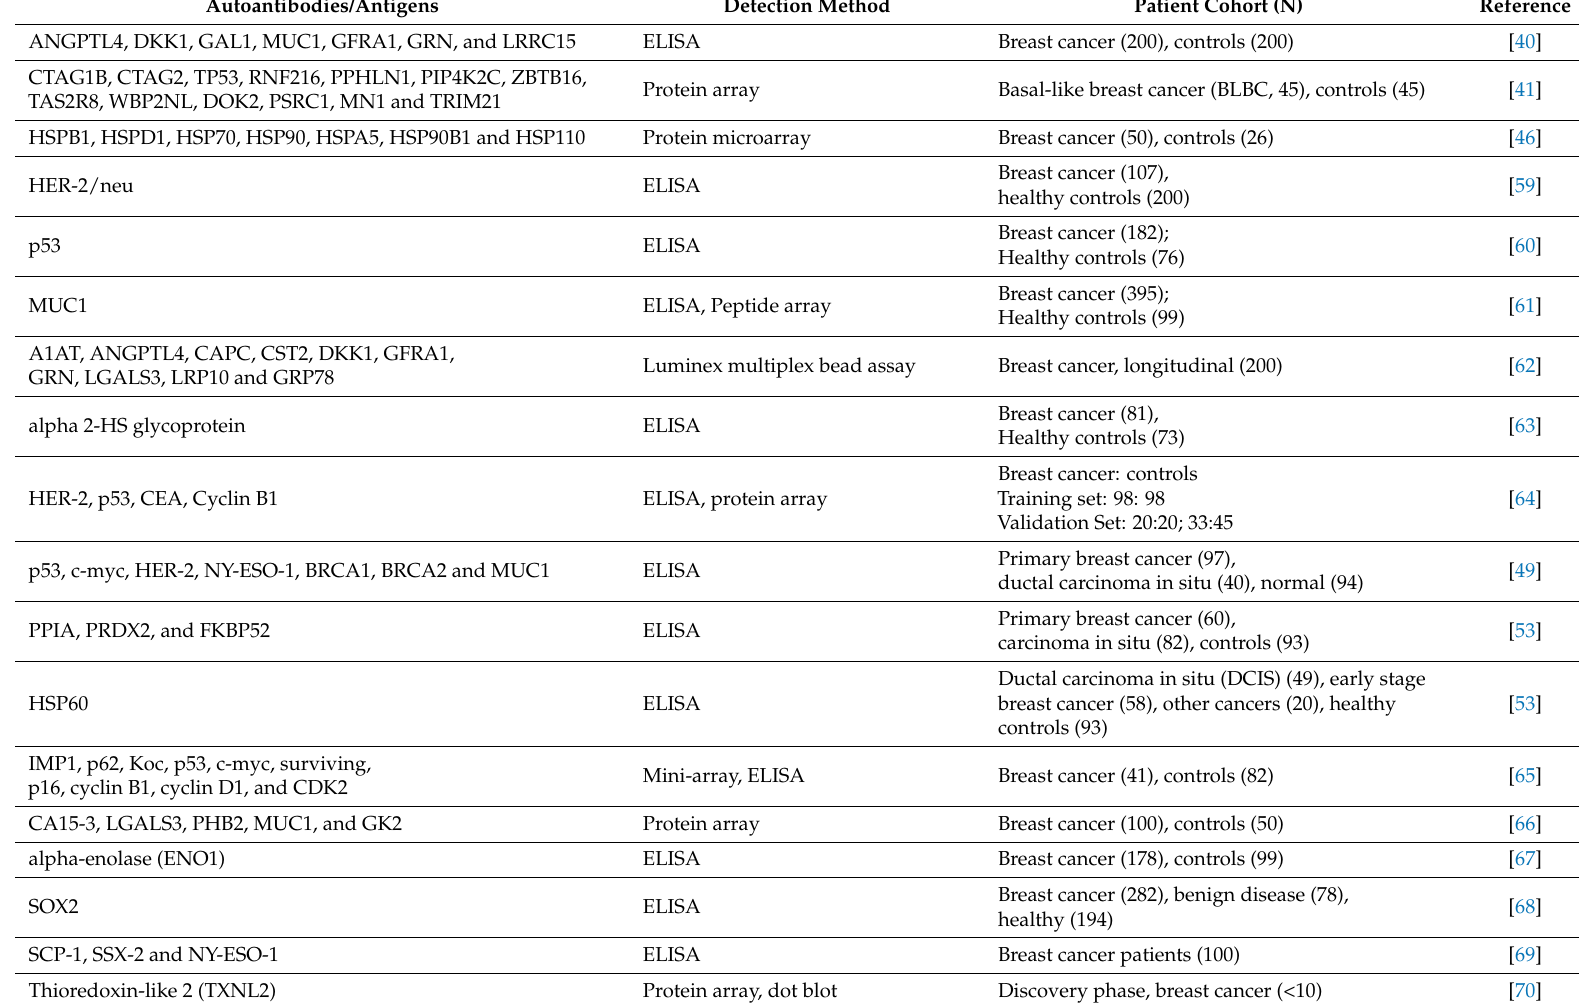
Table 1. Tumor-associated autoantibodies in breast